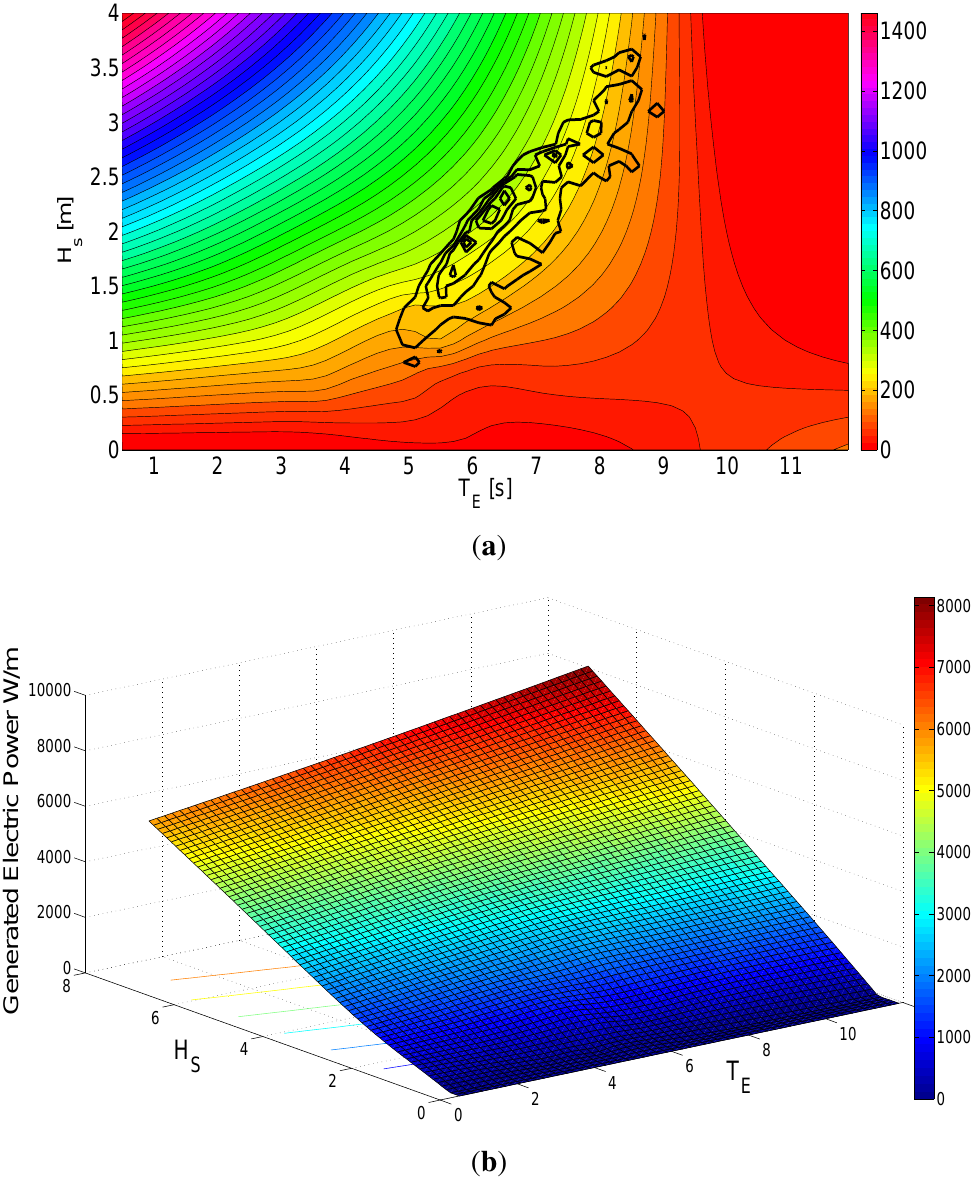
Figure 9. Optimal V as a function of the sea state parameters. ( a ) Optimal DC-level and DC the contours of the available energy; ( b ) Generated power operating at optimal V different sea